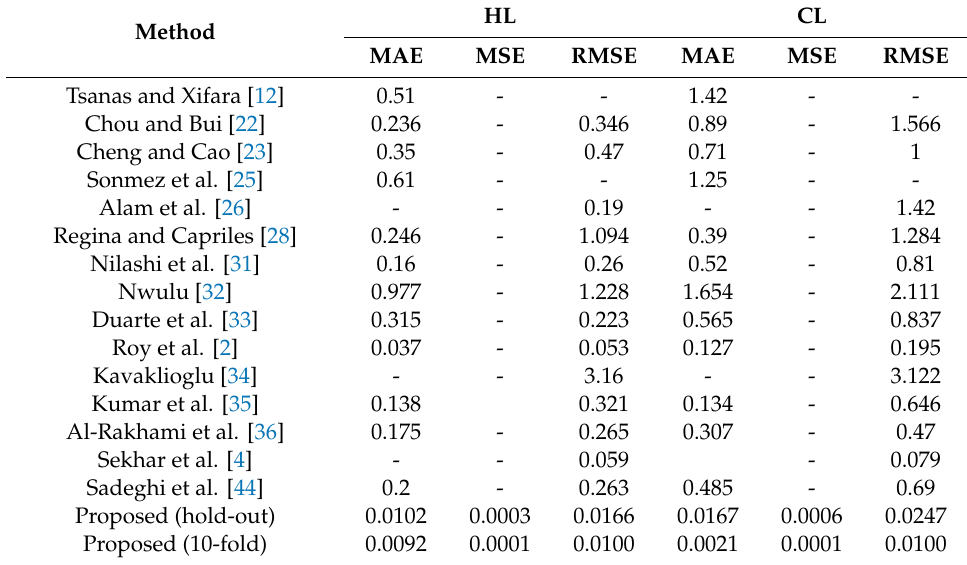
Table 7. Comparison of the proposed model (GRU) for HL and CL prediction with state-of- the-art